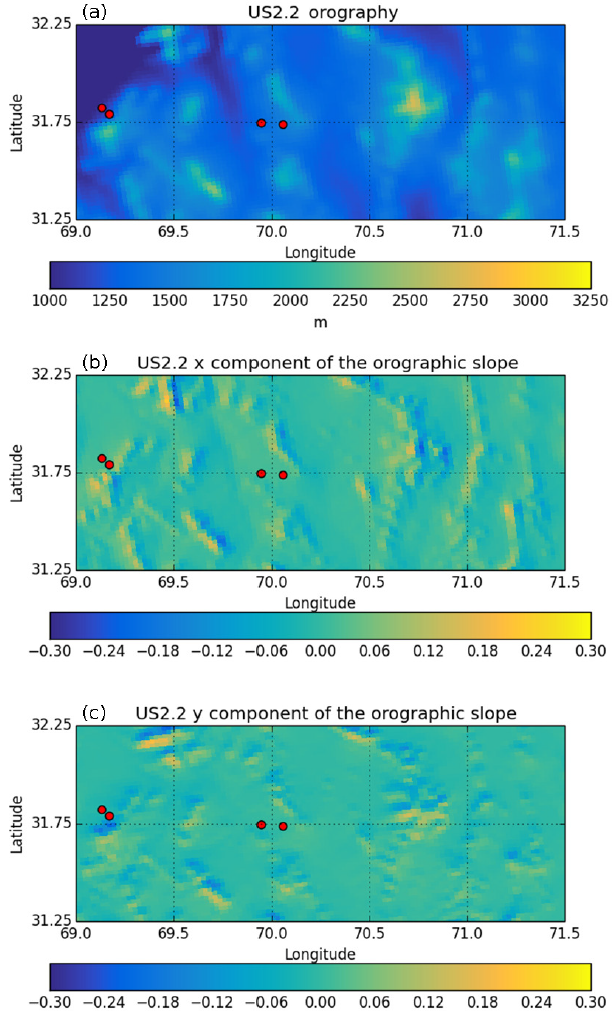
Figure 4. (a) Model orography for the US2.2 configuration. (b) US2.2 x component of the orographic slope, where negative values indicate easterly facing slopes, and positive values indicate westerly facing slopes. (c) US2.2 y component of the orographic slope, where negative values indicate northerly facing slopes, and positive values indicate southerly facing slopes. The red dots represent Lucky Hills (31.75 ◦ N, 110.05 ◦ W), Kendall Grassland (31.73 ◦ N, 109.94 ◦ W), Santa Rita Mesquite (31.82 ◦ N, 110.87 ◦ W) and Santa Rita Grassland (31.79 ◦ N, 110.83 ◦